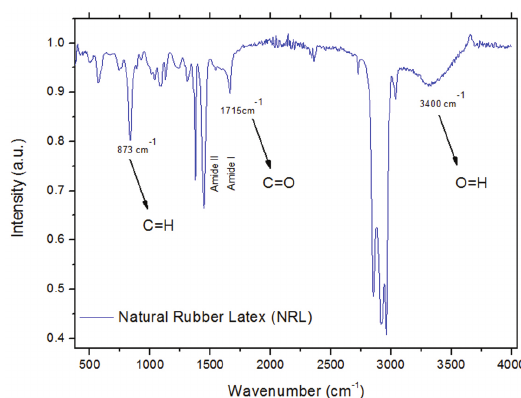
Figure 6. FTIR spectra of natural rubber membranes in ATR method.